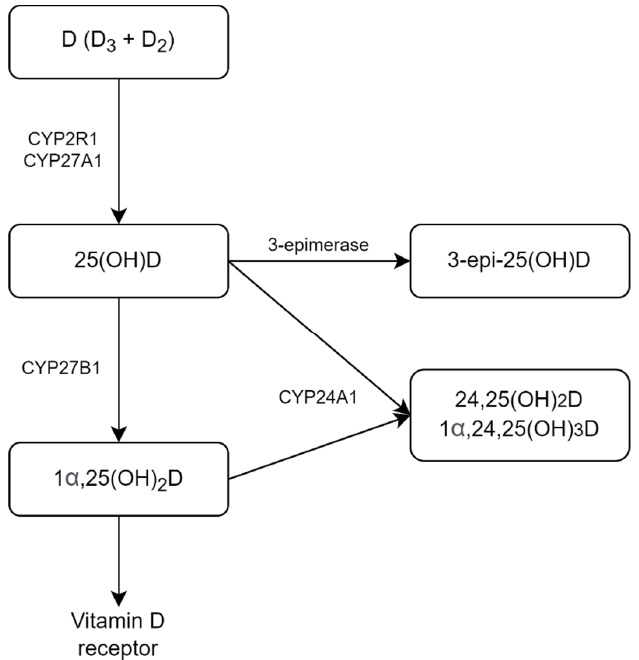
Figure 1. Scheme of vitamin D metabolism.